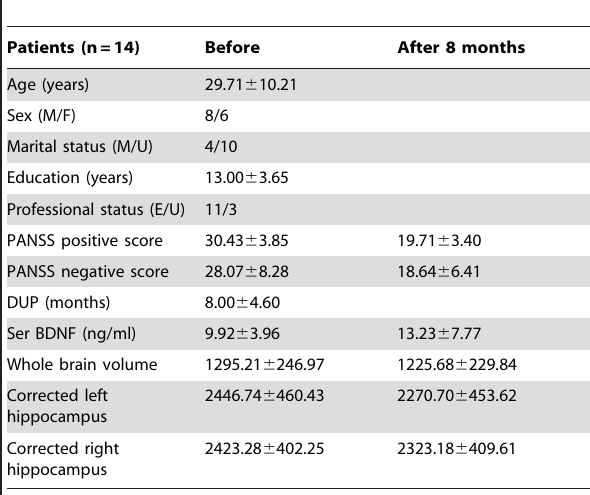
Table 1. Demographic, clinical and neuroimaging characteristics of the study participants.